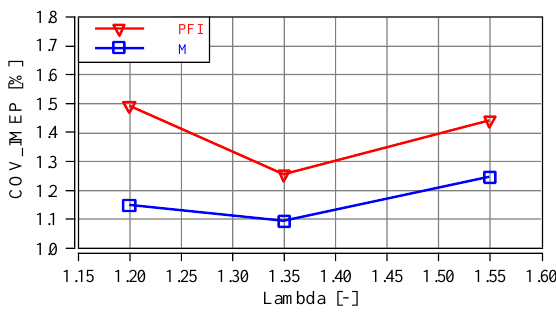
Fig. 6. Effects of injection system on coefficient of variation of indicated mean effective pressure (IMEP) for different charge composition Figure 7 shows the distribution of the number of cycles in which IMEP falls within a given range for three selected λ values. In the case of the leanest mixture, larger IMEP values were obtained by using injection before the intake valve. Then, along with the decreasing value of λ, the IMEP value increased in favor of the mixer system. This is proba- bly due to the loss of the fresh fuel dose generated by the mixer when the timings overlapped. The air-fuel equiva- lence ratio increased by increasing the pressure in the intake system, which promoted the flow of fresh fuel dose remain- ing from the previous cycle directly to the exhaust system.